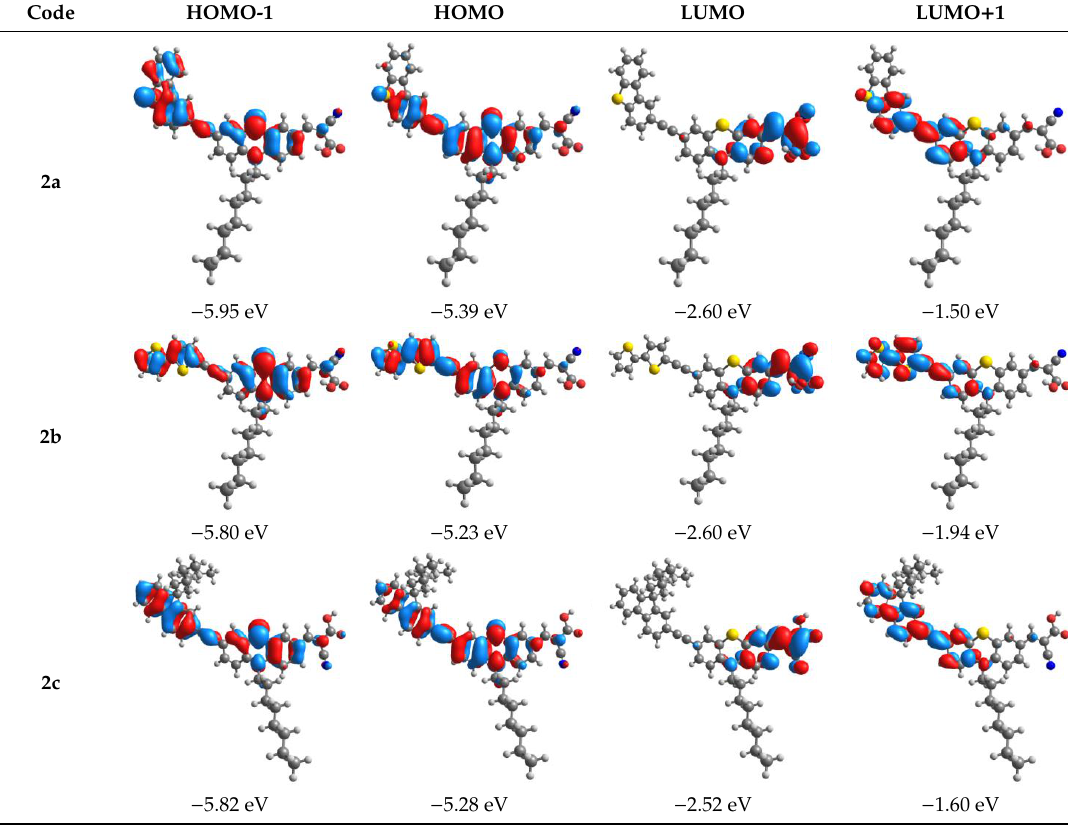
Table 2. The optimized structures (6-31G(d,p) / B3LYP), contours and selected orbitals with their energy for compounds 2a–2c.